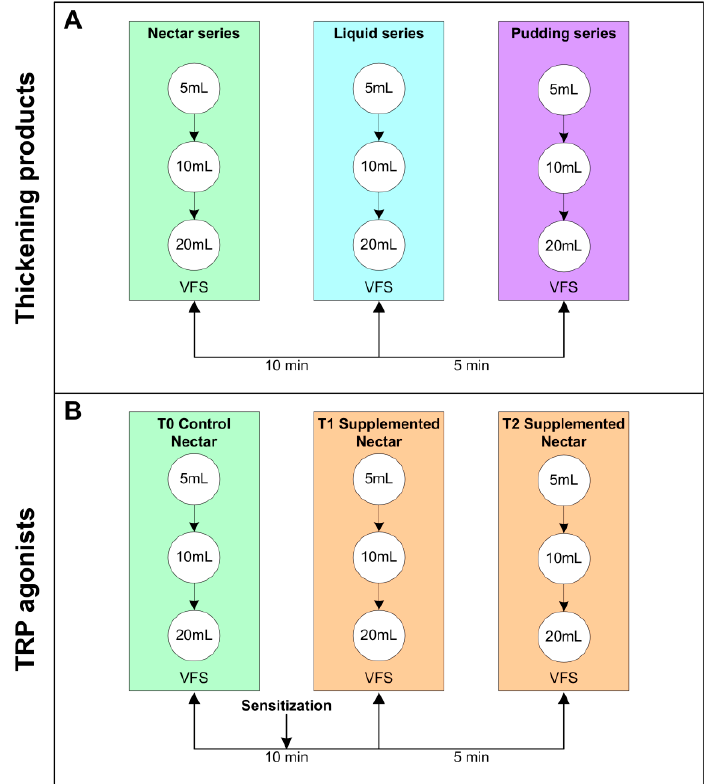
Figure 8. Videofluoroscopy (VFS) algorithm for each type of treatment: ( A ) thickening products and ( B ) TRP agonists.